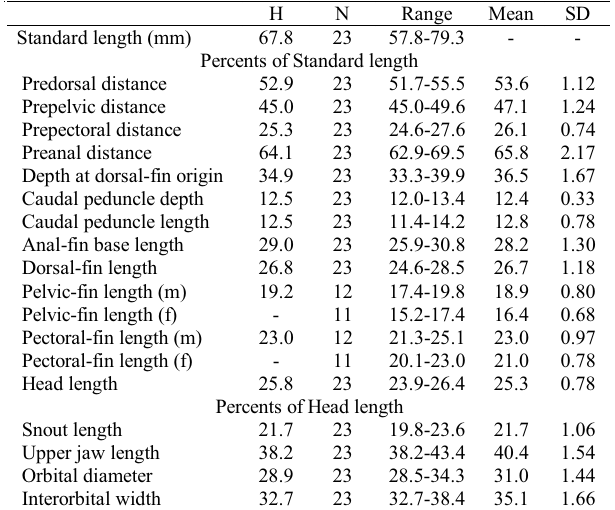
Table 1. Morphometric data of holotype (H, male) of Astyanax utiariti , and paratypes (MCP 40041) from rio Papagaio, tribu- tary of rio Juruena, upper rio Tapajós drainage, Sapezal, Mato Grosso, Brazil. (N = 23 including the holotype; m, males; f,